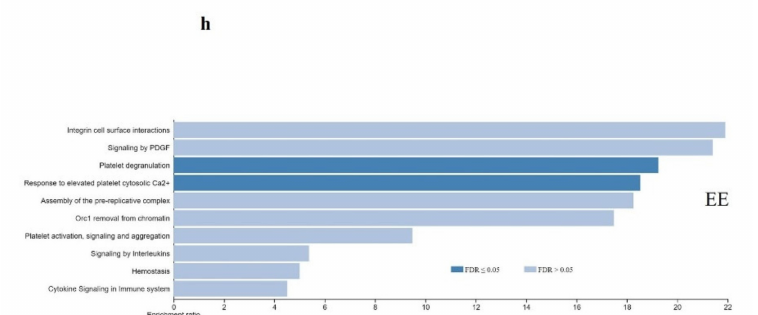
Figure 4. Classification of proteins overexpressed in aortic valvular endothelium (AVE) and endocardial endothelium (EE). A list of proteins in AVE cells (29 genes) was used for the analysis, 28 genes were mapped to unique Entrez gene IDs, and 1 gene symbol was not mapped to any IDs. A list of proteins in EE cells (25 genes) was used for the analysis, 23 genes were mapped to unique Entrez gene IDs, and 2 gene symbols were not mapped to any IDs. The bar chart represents Entrez gene IDs overlapped with gene ontology (GO) slim categories such as biological process ( a , b ), cellular component ( c , d ), and molecular function ( e , f ). The bar chart represents the top 10 enriched pathways in AVE cells and EE cells using the Reactome database ( g , h ). The darker bar represents FDR for less than or equal to 0.05, while the lighter shade represents FDR > 0.05. The top 10 pathways with a p -value < 0.05 are selected for the representation. All classification analysis was performed in WebGestalt